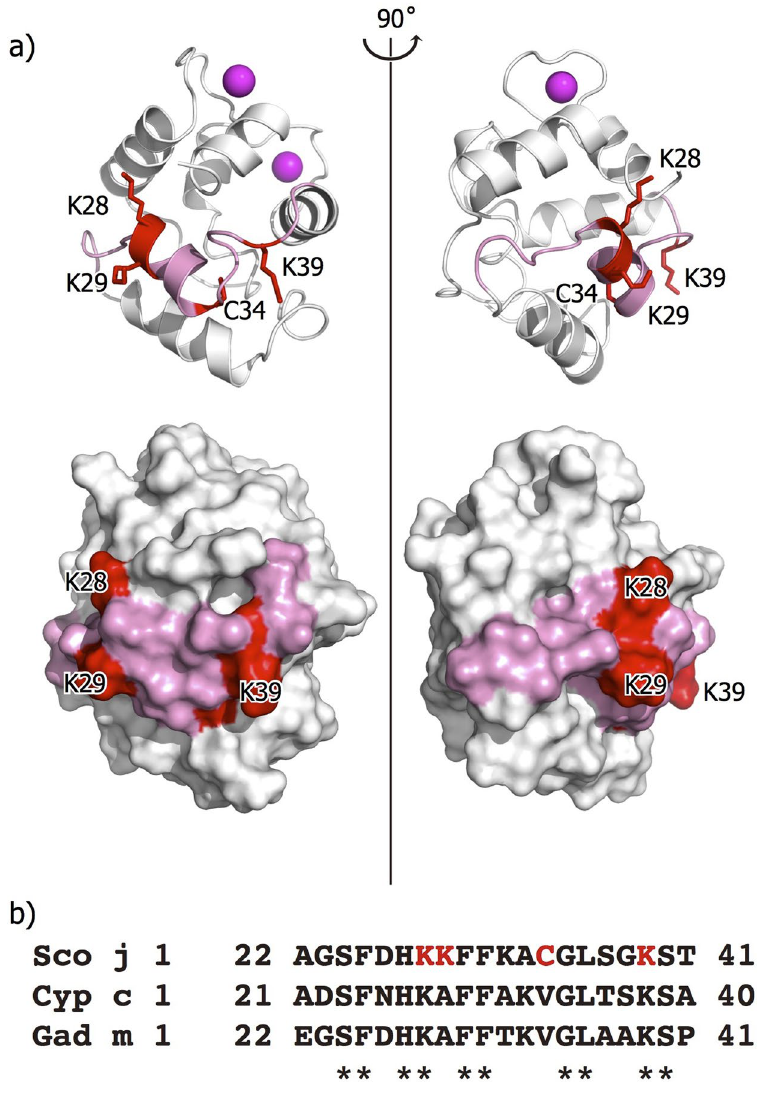
Figure 3. Epitope region of Sco j 1 structure. ( a ) Ribbon (upper) and surface (lower) diagram of the Sco j 1 structure. Epitope region is colored in red (Lys28, Lys29, Cys34, and Lys39) and pink (Ala22 to Thr41), respectively. ( b ) Sequence alignment of epitope region (Ala22 to Thr41) of parvalbumins Sco j 1, Cyp c 1 and Gad m 1. Lys28, Lys29, Cys34, and Lys39 of Sco j 1 are colored red. Fully conserved residues are shown by